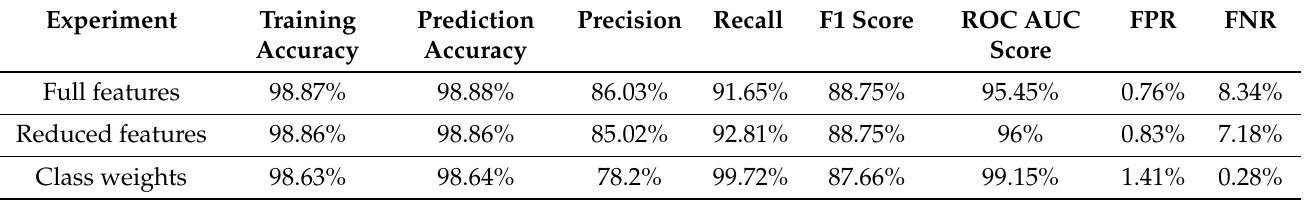
Table 23. Comparison of the results achieved in the UNSW-NB15 binary classification